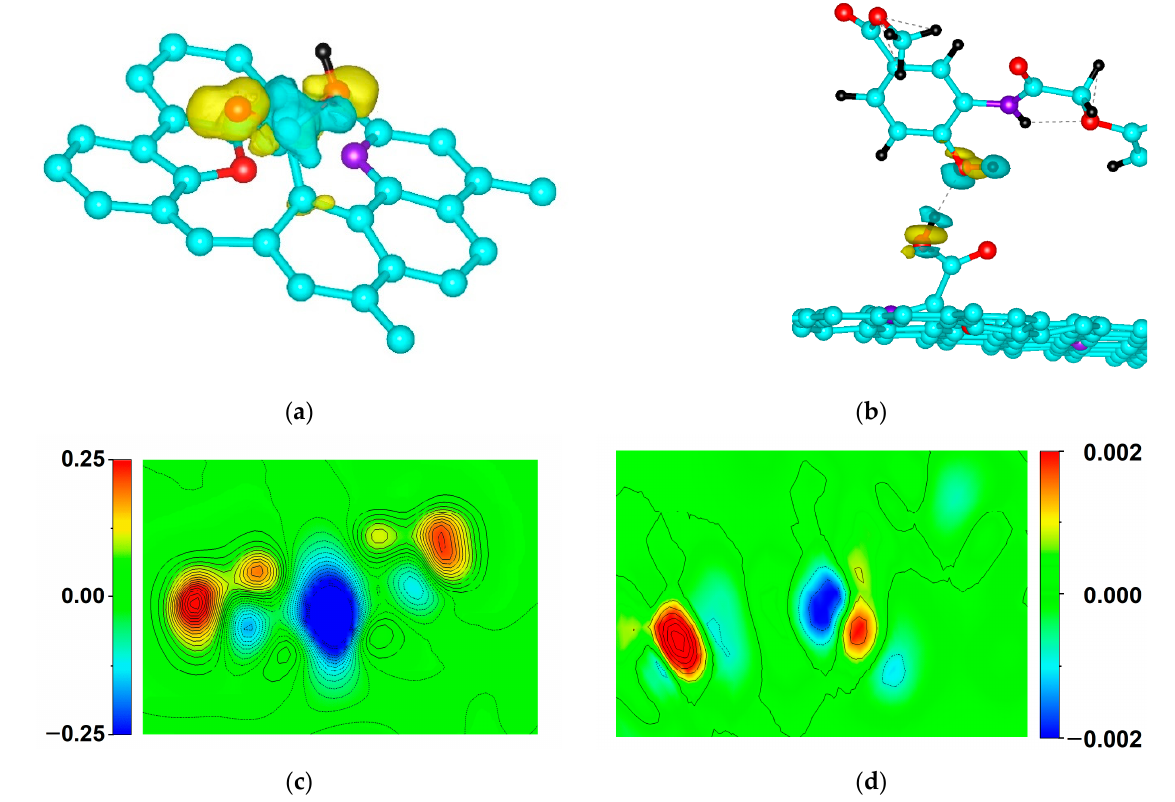
Figure 8. Comparison of electron density distribution between carboxyl and HIF-1 α molecule: ( a ) Spatial location of carboxyl; ( b ) Spatial location of and HIF-1 α molecule; ( c ) Electron density distributions in carboxyl and tube; ( d ) Electron density distributions in HIF-1 α molecule and carboxyl.